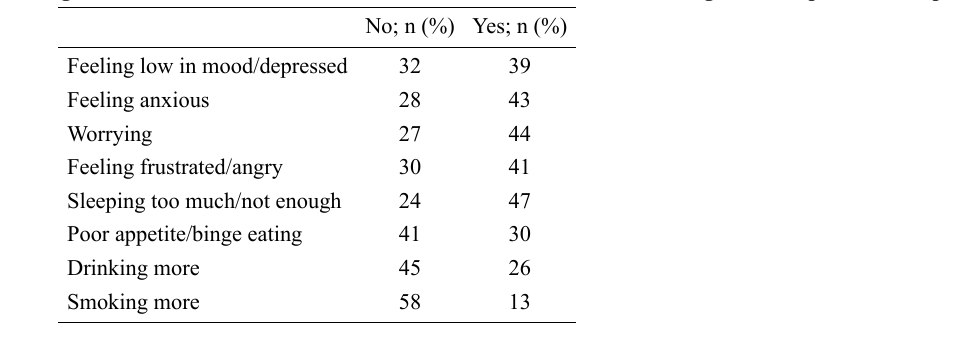
Mental health and behavioural outcomes Feeling low in Feeling Worrying Feeling frus- Sleeping too Poor appetite/binge Drinking mood/depressed anxious much/not enough eating more more